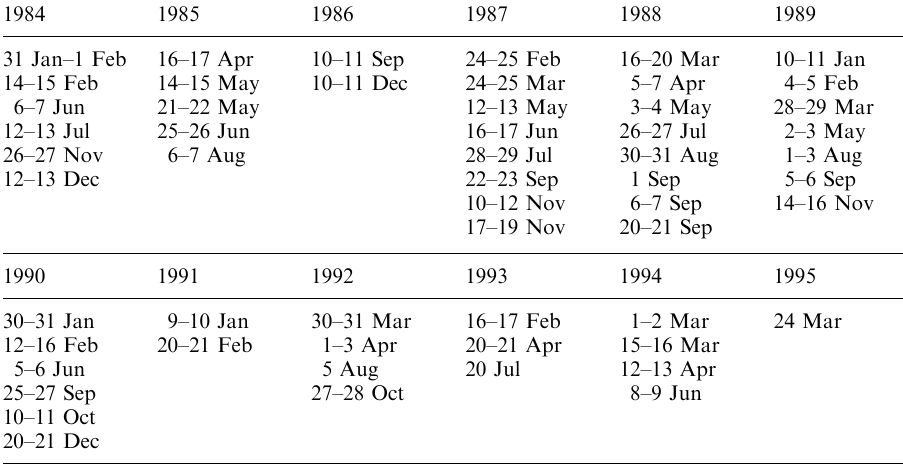
Table 1. Dates of experiments over a full solar